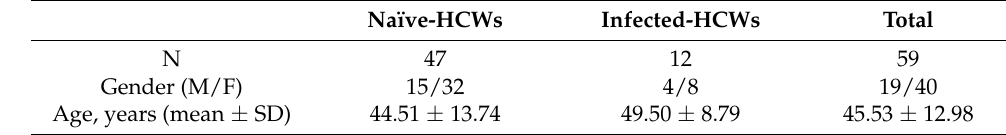
Data are expressed as mean ± standard deviation (SD); HCWs: healthcare workers; M: male; F: female N: